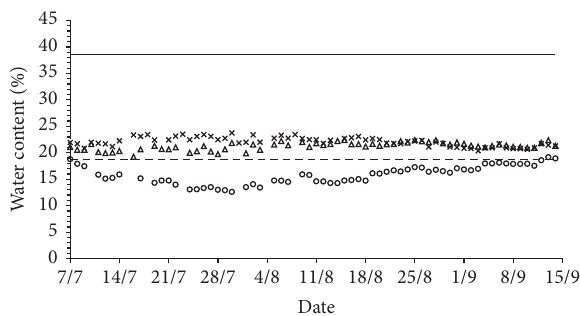
Figure 7: Temporal soil water content variation in the soil depth 𝑍 = 50 cm: at the inlet 𝑋 = 0 ( × ), at the behalf 𝑋 = 𝐿/2 ( 󳵻 ), and at the lateral end tip 𝑋 = 𝐿 (o)against ( 𝜃 +Δ𝜃 −Δ𝜃 ) solid and ( 𝜃 ) dashed lines. op op op op